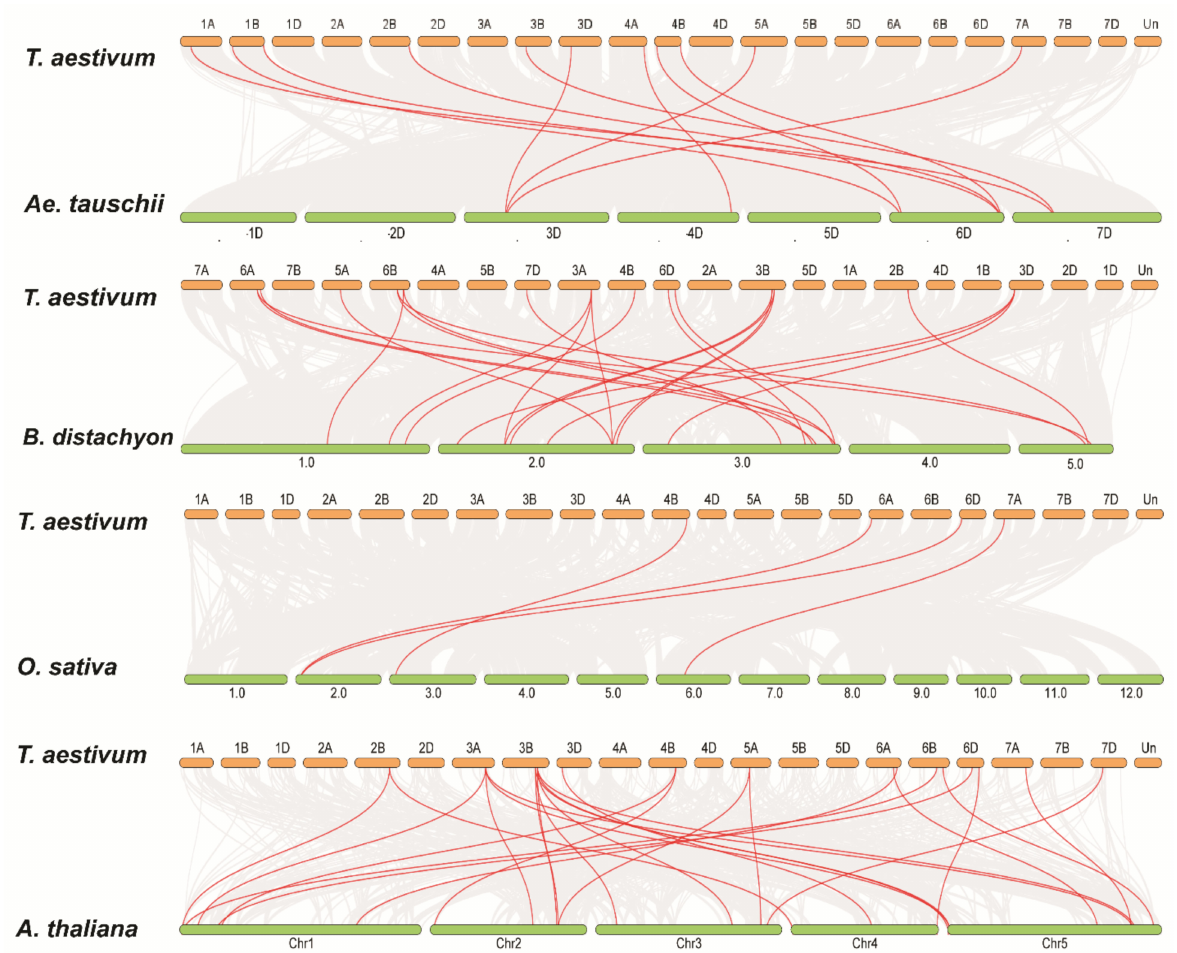
Figure 4. Syntenic connections of TaACO genes between A. tauschii, B. distachyon, O. sativa , and A. thaliana . The gray lines in the background denote the collinear blocks within T. aestivum and other plant species genomes, whereas the red lines indicate the syntenic ACO gene